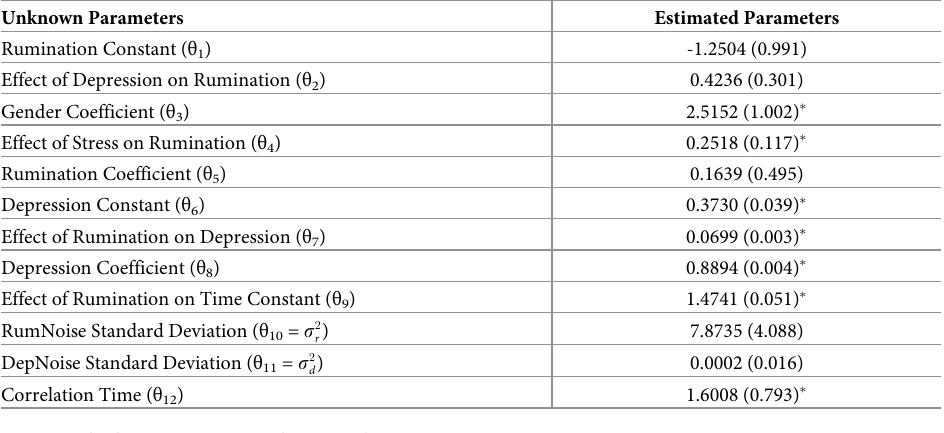
Table 2. Estimated parameters using indirect inference.